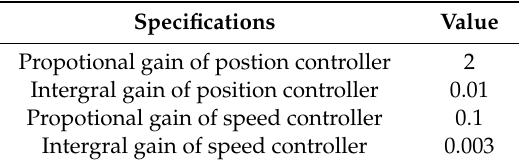
Figure 18. Responses of the motor under a sinusoidal wave reference. Table 2. The parameters of controllers.